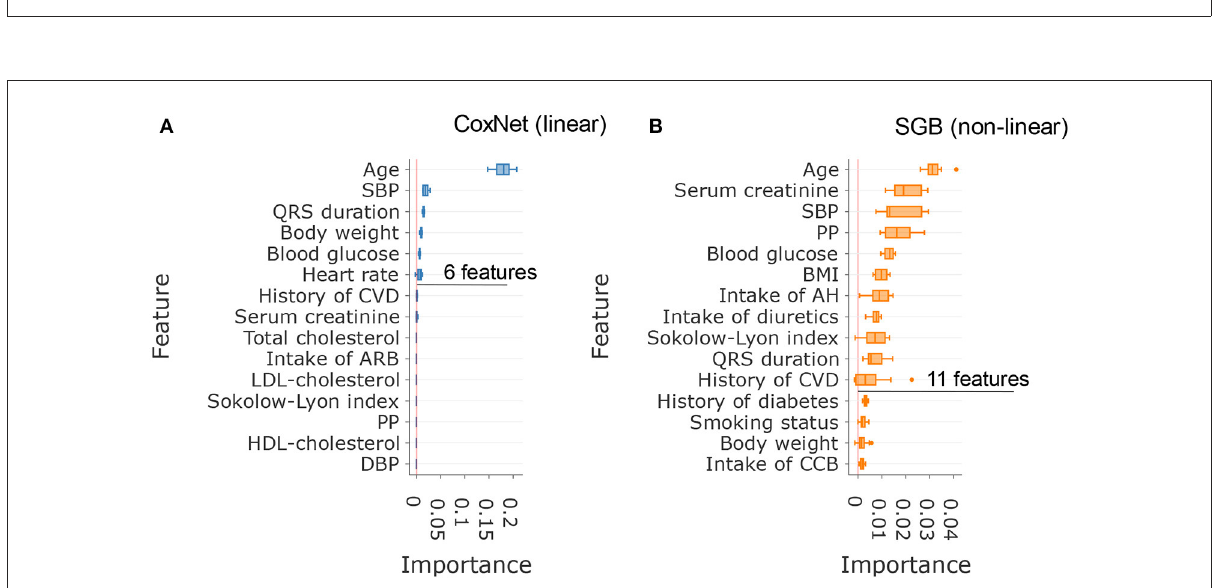
FIGURE3 Comparison of the most important features in CoxNet (A) and survival gradient boosting (B)